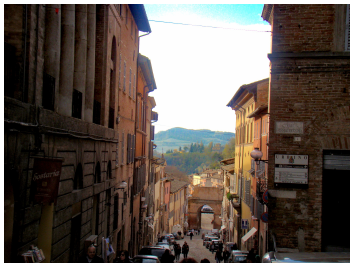
Figure 3. Image where sky restoration